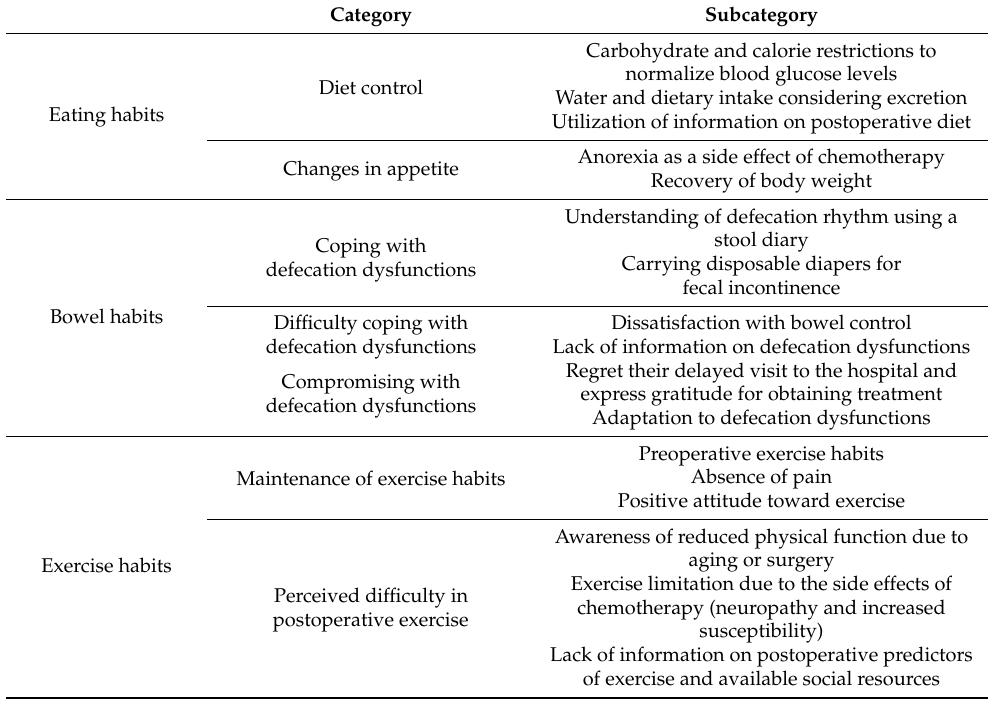
Table 4. Categories of lifestyle impacts in the non-stoma group.